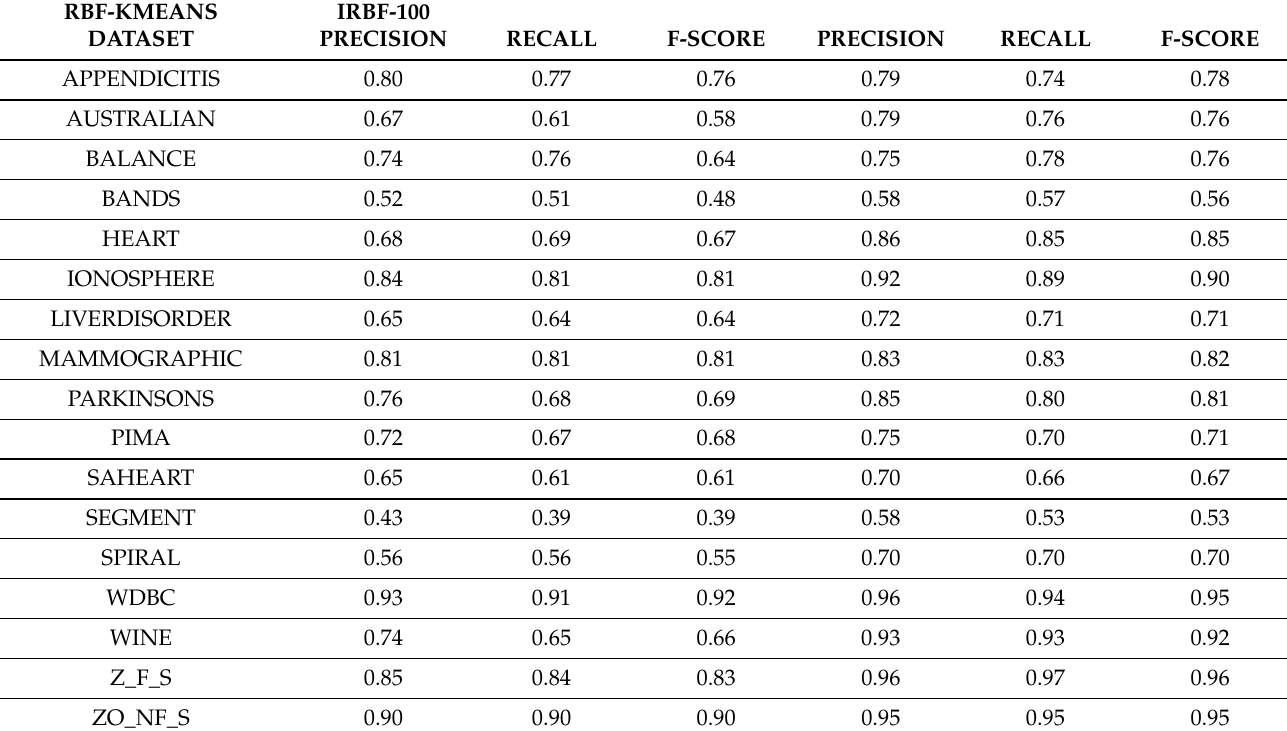
Table 6. Precision, recall, and f-score for a series of classification